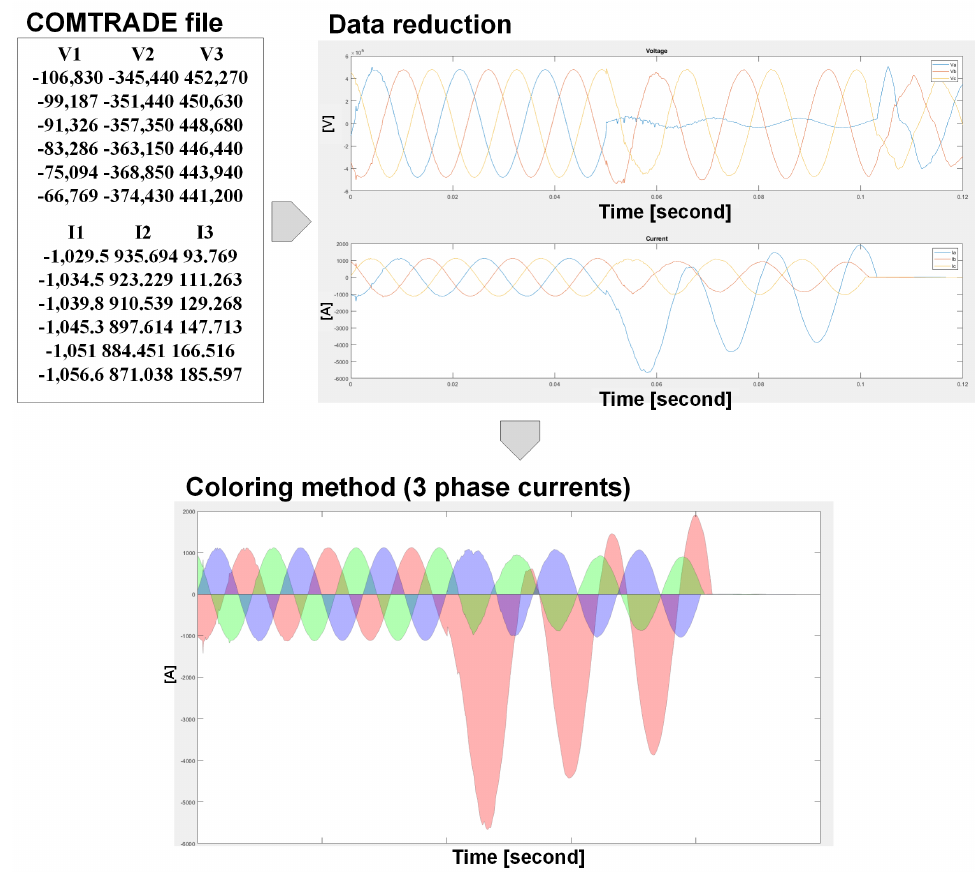
Figure 2. The proposed data preprocessing module. Table 1. Input parameters for training and testing.